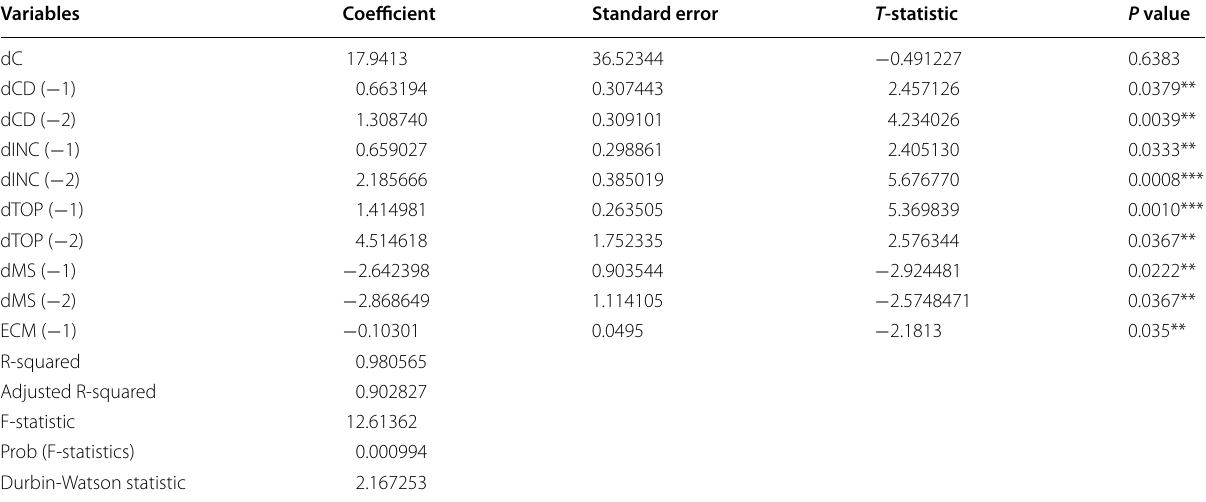
Source Computed using Microfit